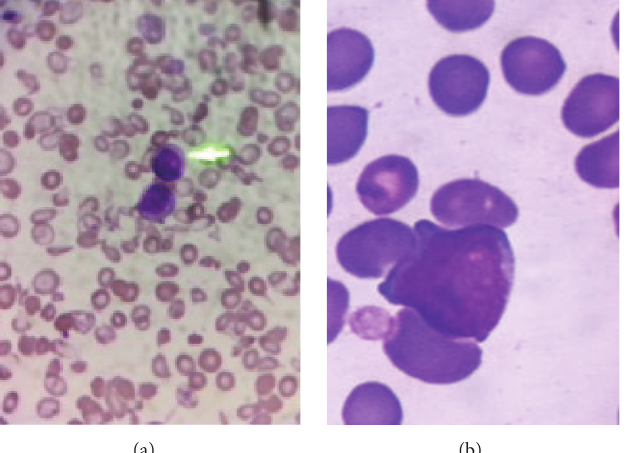
Figure 1: Peripheral smear showing tear drops and fragmented and target red cells. Myeloblasts are shown with yellow arrow (a). Myeloblasts showed high nuclear/cytoplasmatic ratio (b).